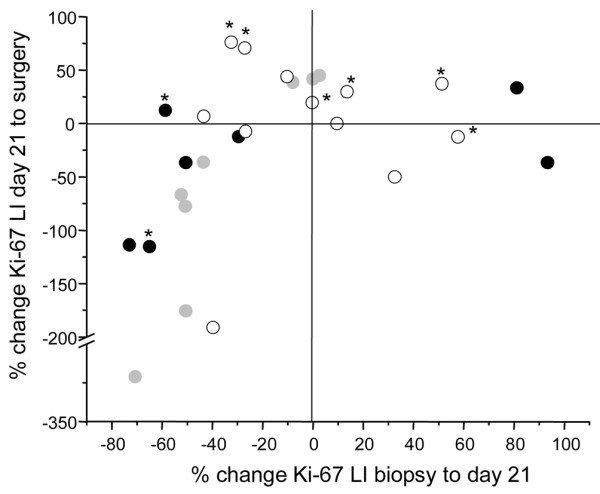
Changes in Ki-67 LI during treatment and clinical and pathological response. The data are expressed as % change between initial biopsy and day 21 relative to the initial biopsy score (x-axis) versus % change between day 21 and surgery relative to the day 21 index. (●) represents patients with a complete clinical response, (●) with a partial response and (○) represents no response. The asterisks represent those patients who achieved a pathological response.